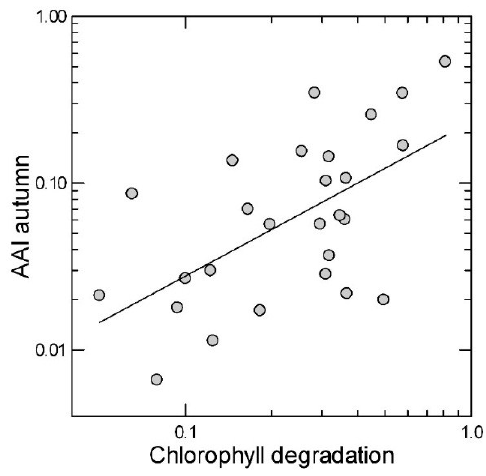
Figure 5. Leaf anthocyanin contents in autumn, expressed as Anthocyanin Absorbance Index (AAI, absorbance at 532 nm minus 24% of absorbance at 653 nm [24]) plotted against earliness of senescence, expressed as the proportion of chlorophyll degraded by mid-September, compared to chlorophyll summer values, among 27 red maple trees. Average values for 2005 and 2006. r = 0.603, p <